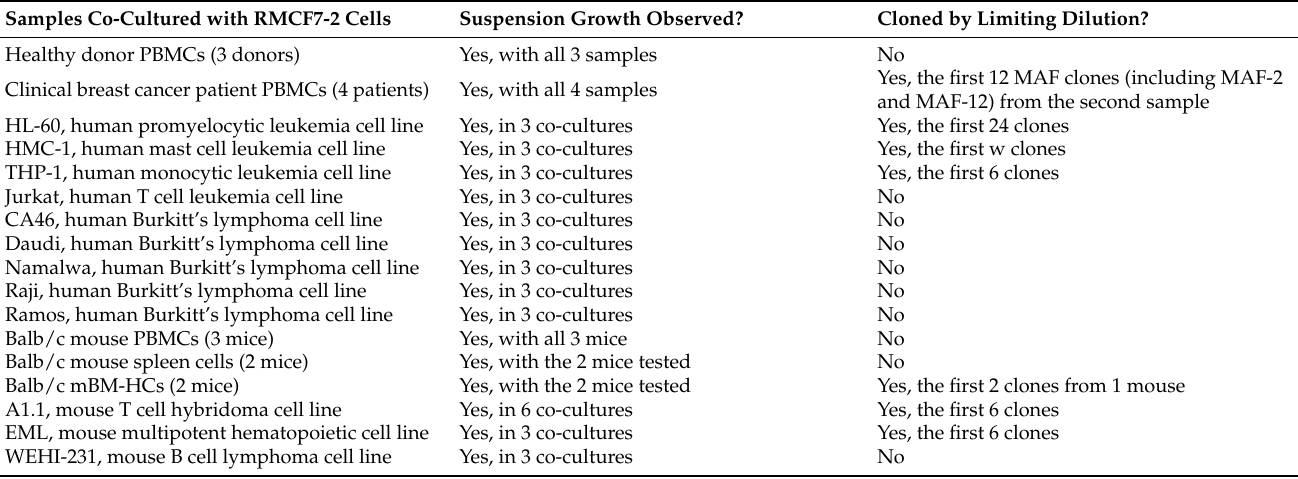
Table 1. Appearance of red florescent cells in suspension growth from co-cultures with RMCF7-2 cells.